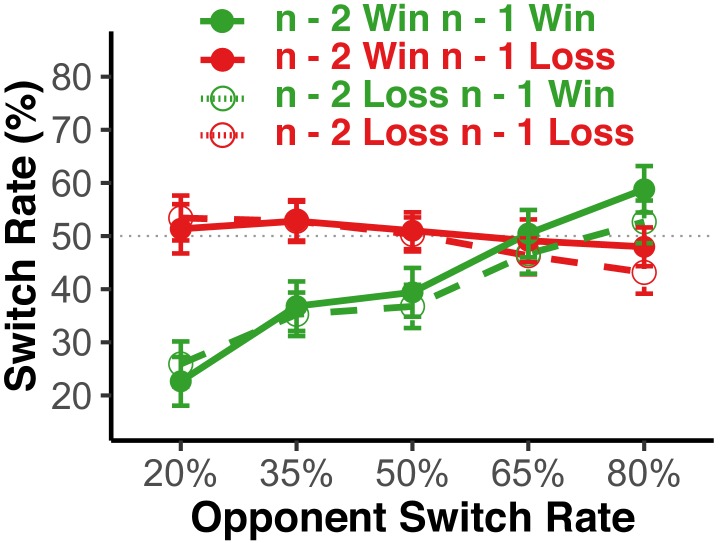
Are feedback effects temporary?Our model assumes that the effect of loss-feedback does not eliminate the model of the opponent, but rather depresses it temporarily. Thus, we should expect that win-loss feedback has a large effect on the next-trial choice, and either no, or only a small effect thereafter. The figure shows for Experiment 1 the switch-rate function from Figure 2, but further conditioned on the trial n-2 win-loss feedback. As apparent, choice behavior is dominated by the effect of trial n-1 feedback. Error bars show 95% within-subject confidence intervals. There was small additional effect of trial n-2 feedback, such that model-based behavior was strengthened following two consecutive wins and stochastic behavior was strengthened following two loss trials (i.e., after two win-trial in a row, the switch-rate function slope becomes more positive, after two loss-trials the function becomes more shallow). Analyzing these data with an ANOVA with the factors trial n-2 and trial n-1 feedback as well as a linear contrast for the opponent switch-rate factor, revealed a strong n-1 feedback x switch-rate interaction, F(1,51)=58.45, p<0.001, eta2 = 0.53, and a much weaker, but still reliable n-2 feedback x switch-rate interaction, F(1,51)=15.02, p<0.001, eta2 = 0.23, and no three-way interaction, F(1,51)=.25, p=0.91. The results from the remaining experiments were similar to this pattern, and if anything, showed slightly weaker n-2 feedback effects than in Experiment 1. The fact that there was a small, cumulative effect of trial n-2 feedback indicates some degree of adaptation to consistent win or loss feedback contingencies. Yet, the fact that choices are mainly dominated by trial n-1 feedback indicates quick recovery of the last-used model representation following a subsequent win.